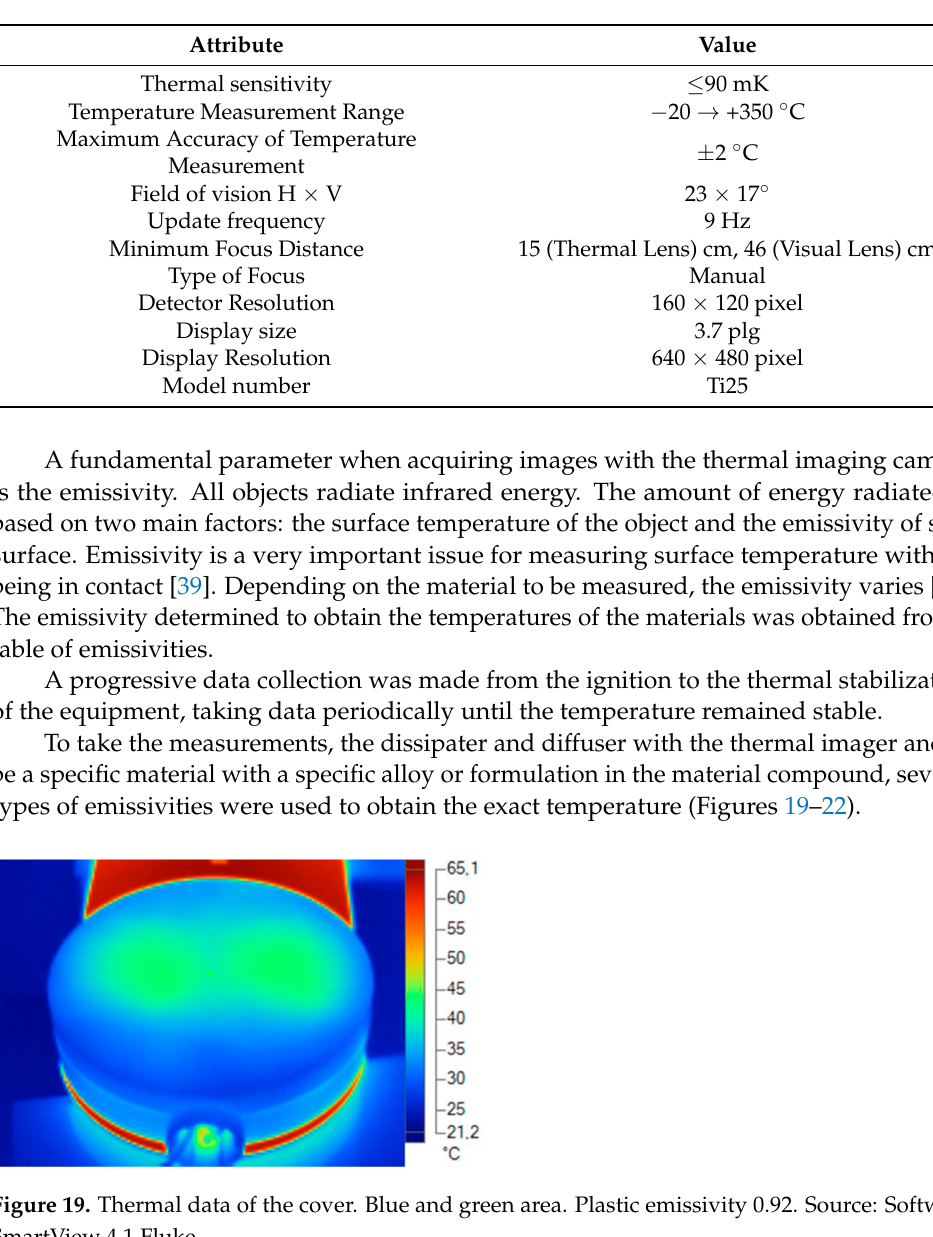
Table 8. Table of specifications of the thermal imager. Source: the user’s manual of the Ti 25 FLUKE thermal camera.